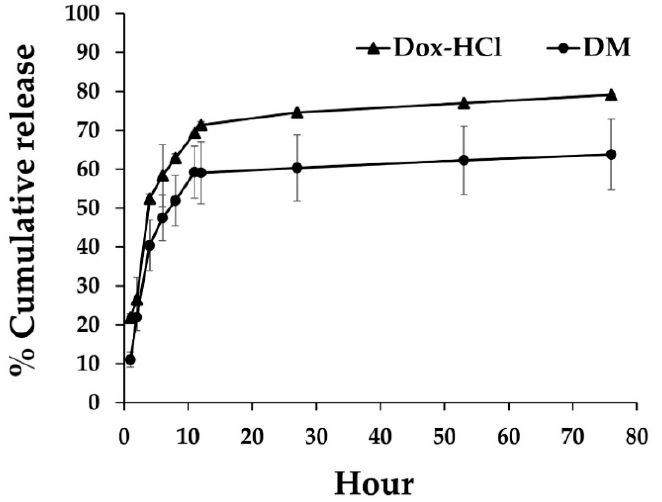
Figure 3. Drug release profiles of Dox from DM and Dox-HCl solution under pH 7.4. Data were presented as mean ± SD ( n = 3). presented as mean ± SD ( n =